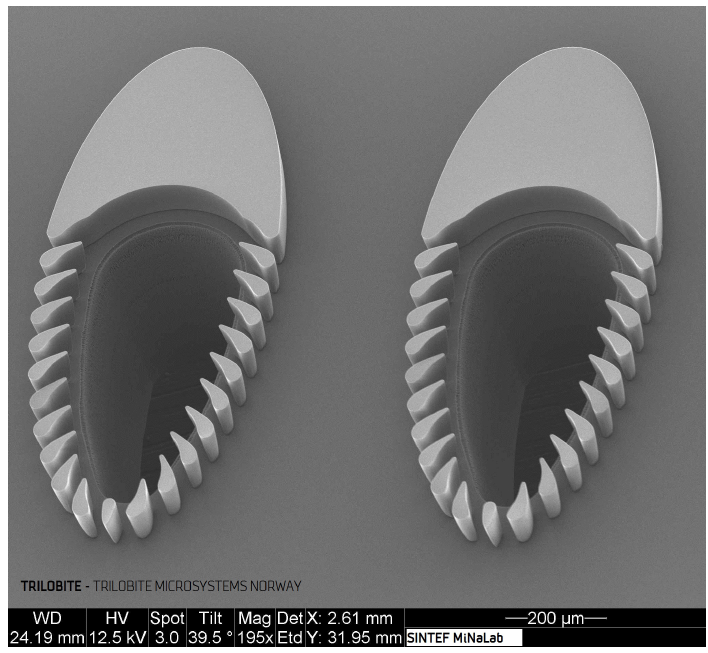
Scanning Electron Microscope (SEM) image showing two trilobite filtration units: the streamlined shape is meant to prevent clogging. The turbine blade-shaped filter blades prevent particles larger than 25 µ m from entering the filtration outlets, seen as the hole in the middle of the trilobite filtration